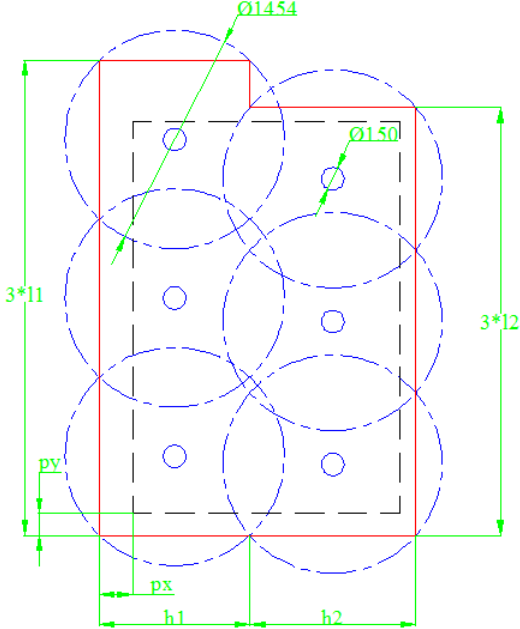
Figure 27. The preliminary partition model of the target points.